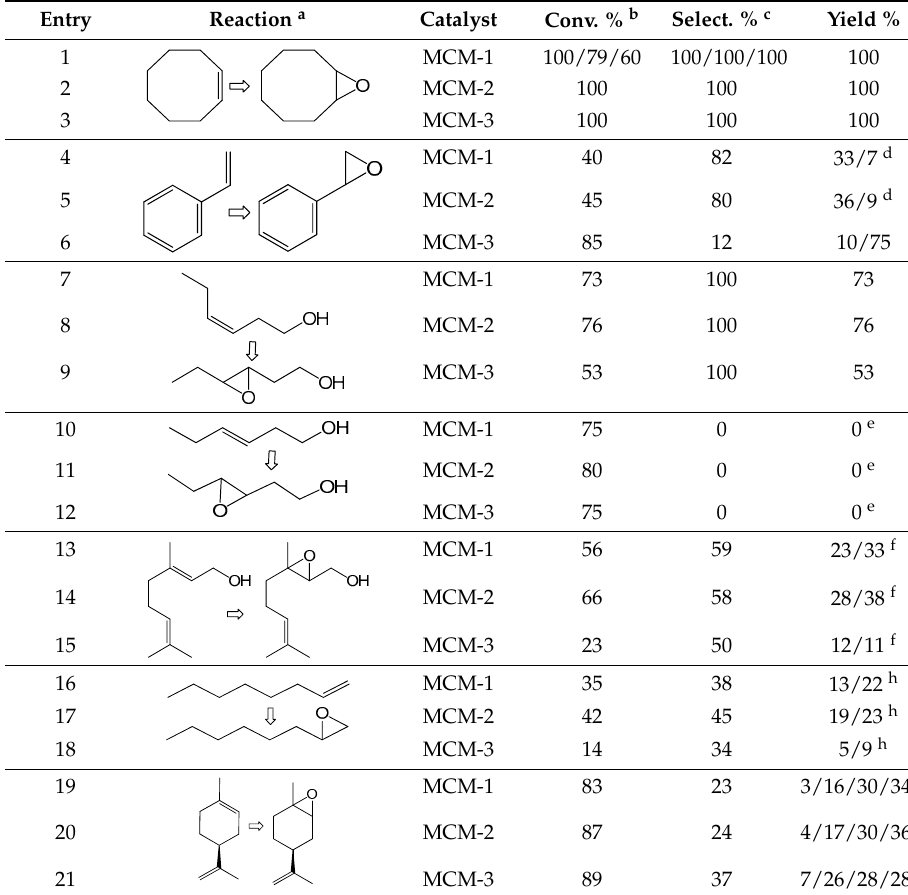
Table 4. Olefin epoxidation of cis -cyclooctene (cy8), styrene (sty), cis -hex-3-en-1-ol ( cis ), trans -hex-3- en-1-ol ( trans ), geraniol (ger), 1-octene (1-oct), and S -(+)-limonene ( S -lim) catalyzed by materials MCM-1, MCM-2, and MCM-3.